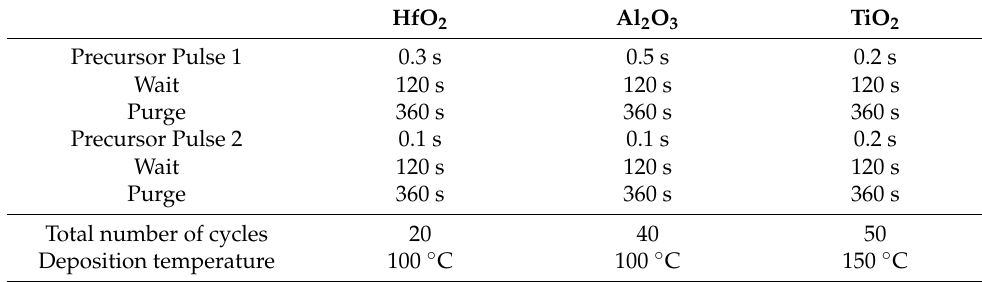
Table 1. Parameters for ALD of different metal oxides in a Fiji F200 ALD reactor. HfO 2 Al 2 O 3 TiO